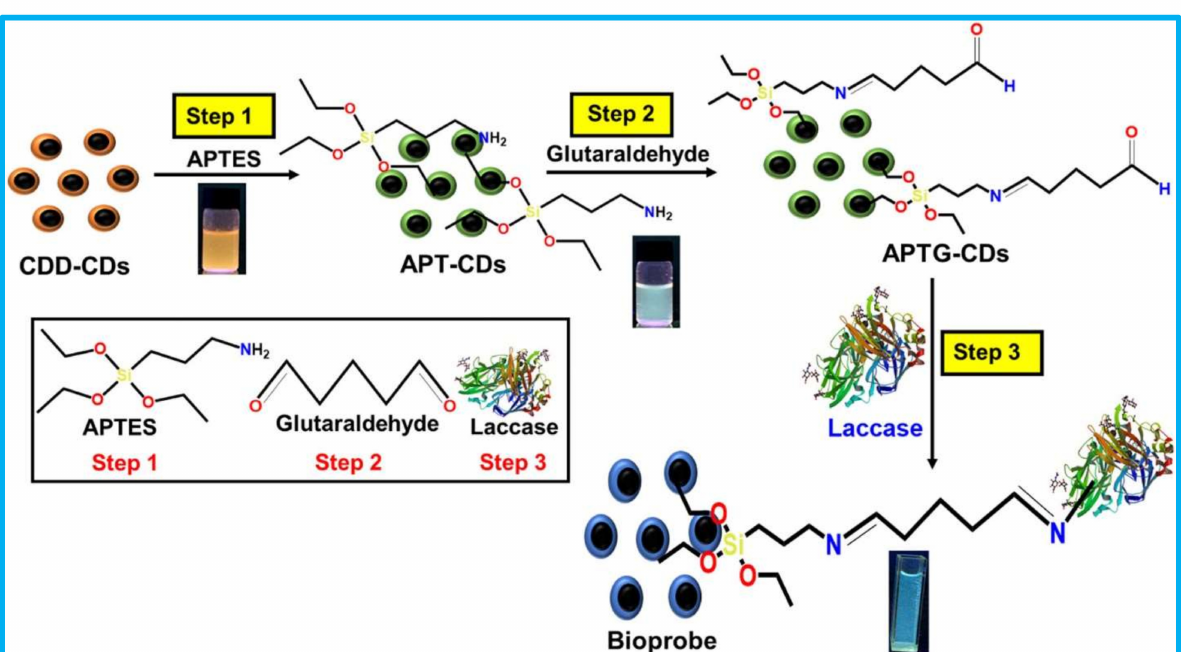
Figure 10. Schematic design for the silica-functionalization of CDD-CDs (curcumin- and dimethylformamide-modified carbon dots) and the laccase covalent immobilization on CDD-CDs via glutaraldehyde. (This image is adapted from the Sangubotla and Kim, 2021 [69] with permission from Elsevier, Amsterdam, The Netherlands (License number